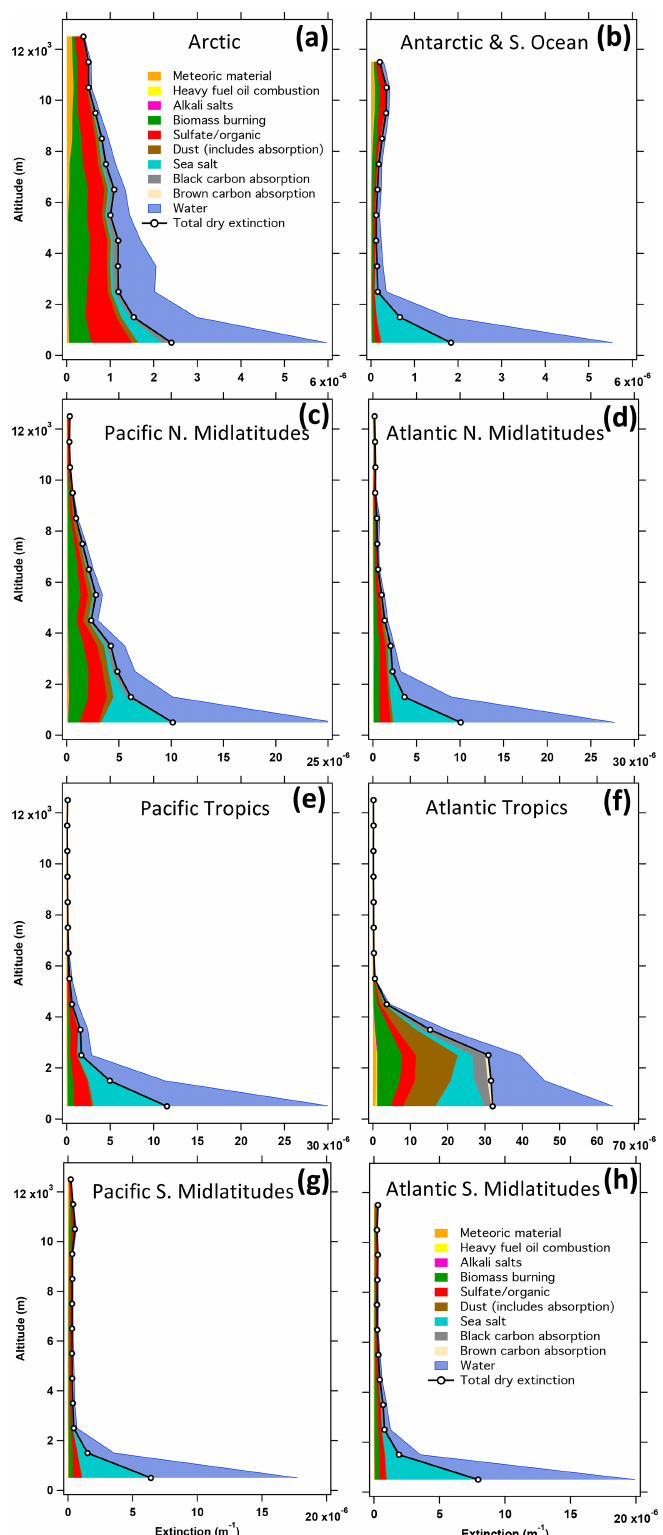
Figure 9. Mean vertical profiles of extinction from each of the aerosol types for different regions across all of the ATom deployments. Note that scales on the x axes vary. Descriptions of the regions are given in Fig. 8 and Table S1. The fractional contribution of the aerosol types to total extinction and the number of data points in each 1km altitude bin are given in Fig.